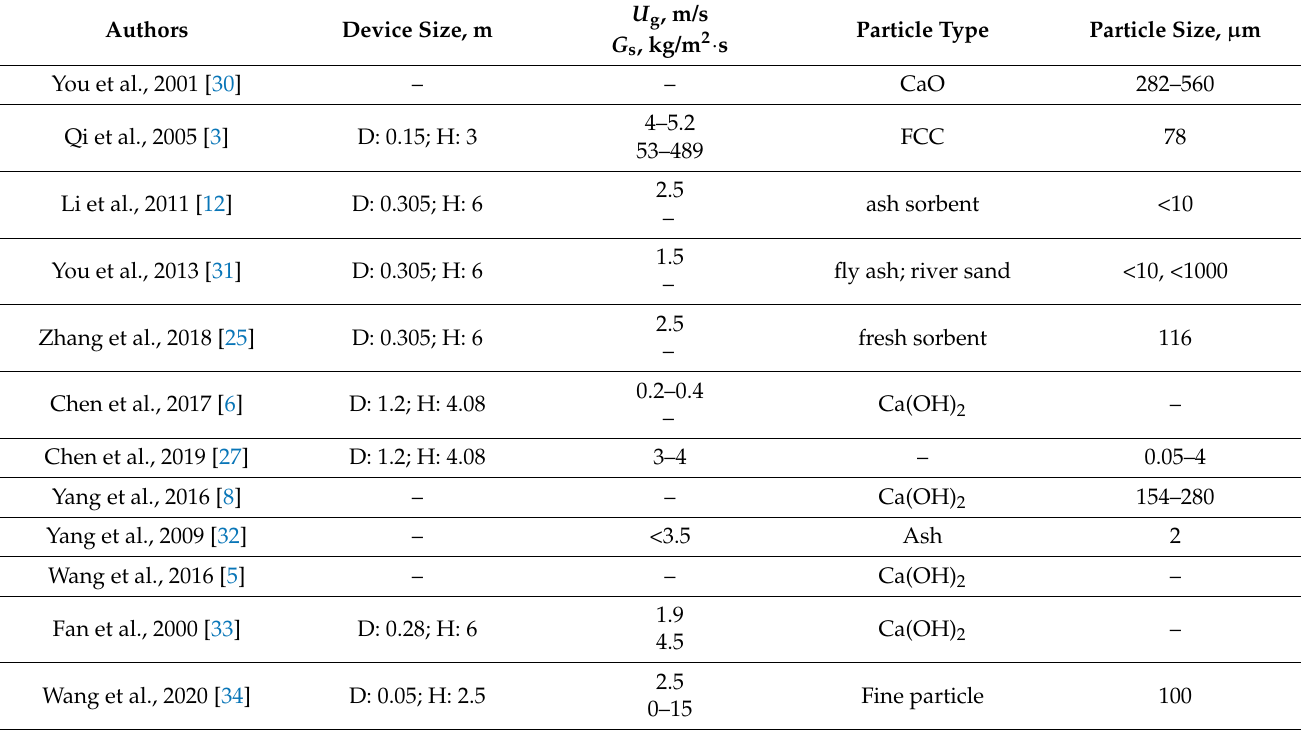
Table 1. Summary of the literature on the research of flue gas